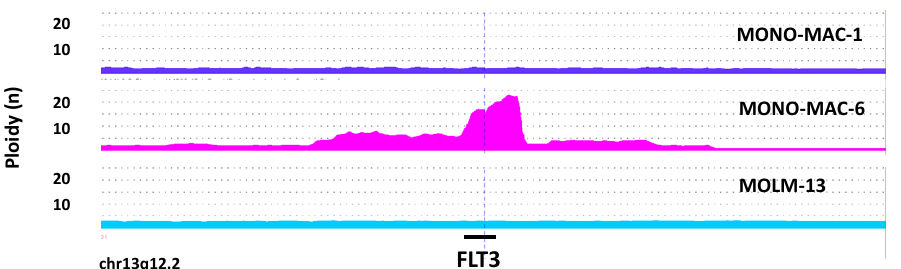
Figure 5. Example of gene overexpression and amplification. (Upper panel) RNAseq analysis revealed FLT3 overexpression in cell line MONO-MAC-6 which is the wild-type (wt) in the FLT3 ITD analysis, whereas cell line MOLM-13 carries the FLT3 ITD. (Lower panel) According to CGH (comparative genomic hybridization) array analysis, the chromosomal region of FLT3 (13q12.2) is highly amplified in MONO-MAC-6 but is not amplified in sister cell line MONO-MAC-1 nor in MOLM-13. Hence, MOLM-13 and MONO-MAC-6 are FLT3 -mutant cell lines whereas MONO-MAC-1 does not have an apparent FLT3